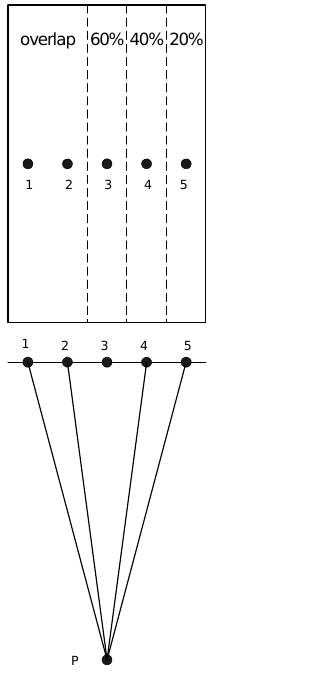
Figure 4. Multiple image pairs may be used to determine the elevation of an object point (P). For image pairs with less over- lap the base/height ratio is increased and the accuracy of the de- rived elevations is improved.